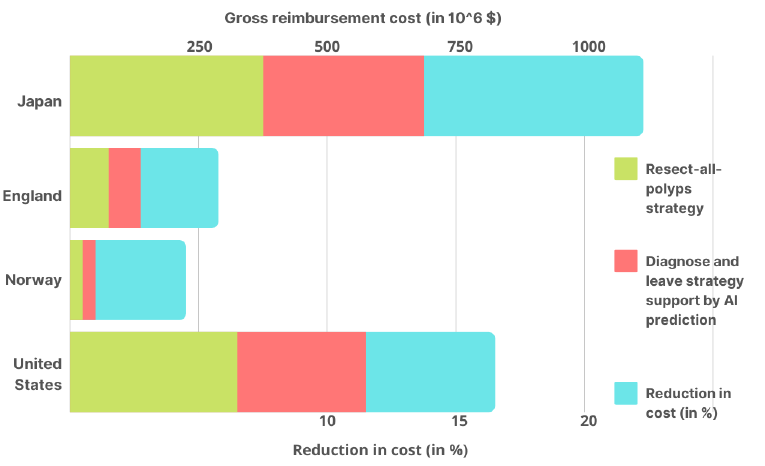
Figure 4. Using the DAL method assisted by AI prediction and the PLR strategy in Japan, the United States, Norway, and England, the estimated gross yearly reimbursement for colonoscopies in each country’s AI cost reduction % is also